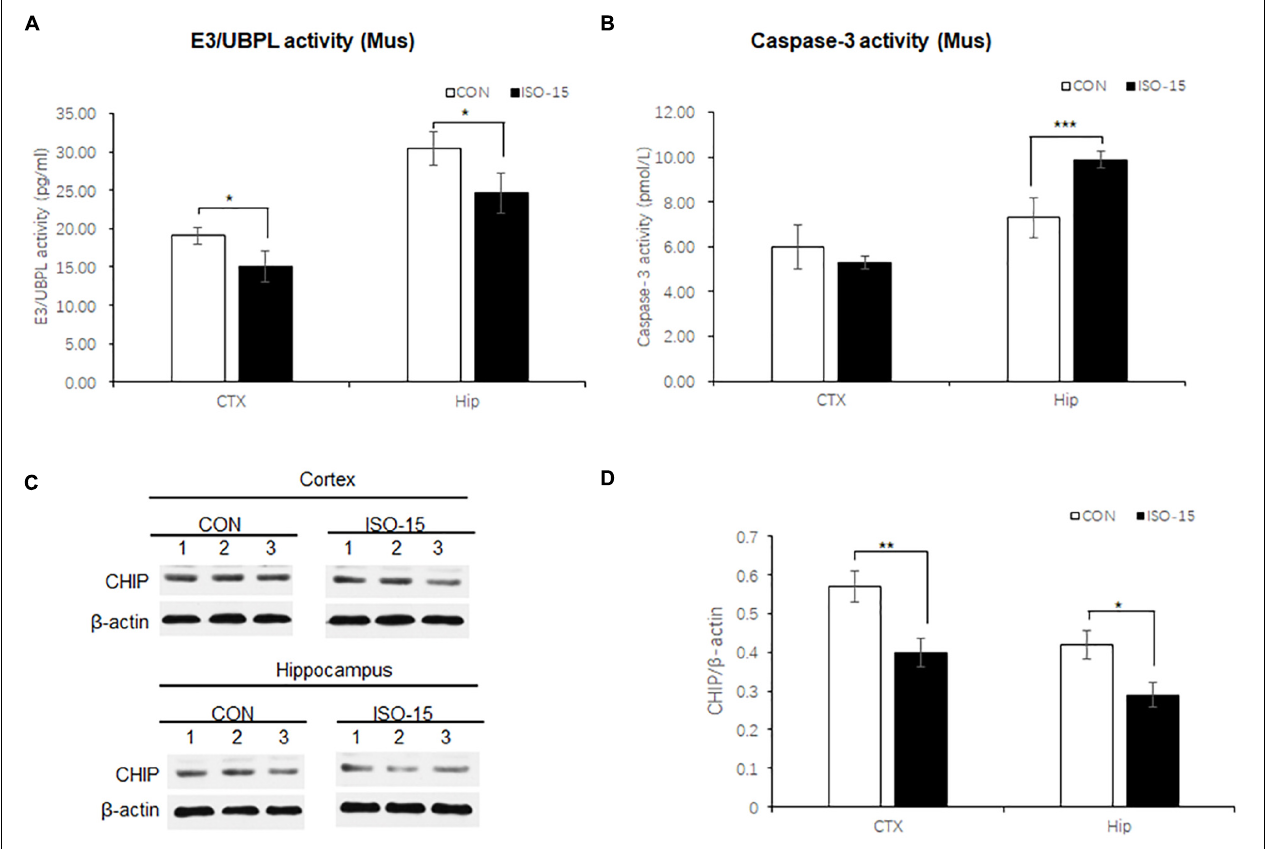
FIGURE 4 | Ubiquitin function was decreased with Ubiquitin E3 ligase CHIP expression decline, and the apoptosis was activated in isoflurane-exposed aged mice. (A) The E3/UBPL activities in the cortex and hippocampus brain region were decreased in the ISO-15 group ( n = 6, * p < 0.05). (B) The caspase-3 activity was increased in the hippocampus in the ISO-15 group ( n = 6, * p < 0.05, *** p < 0.001). (C) CHIP expression was decreased in the cortex and hippocampus brain tissue in the ISO-15 group. (D) Statistical bar chart to show that CHIP expression was present ( n = 6, * p < 0.05, ** p <